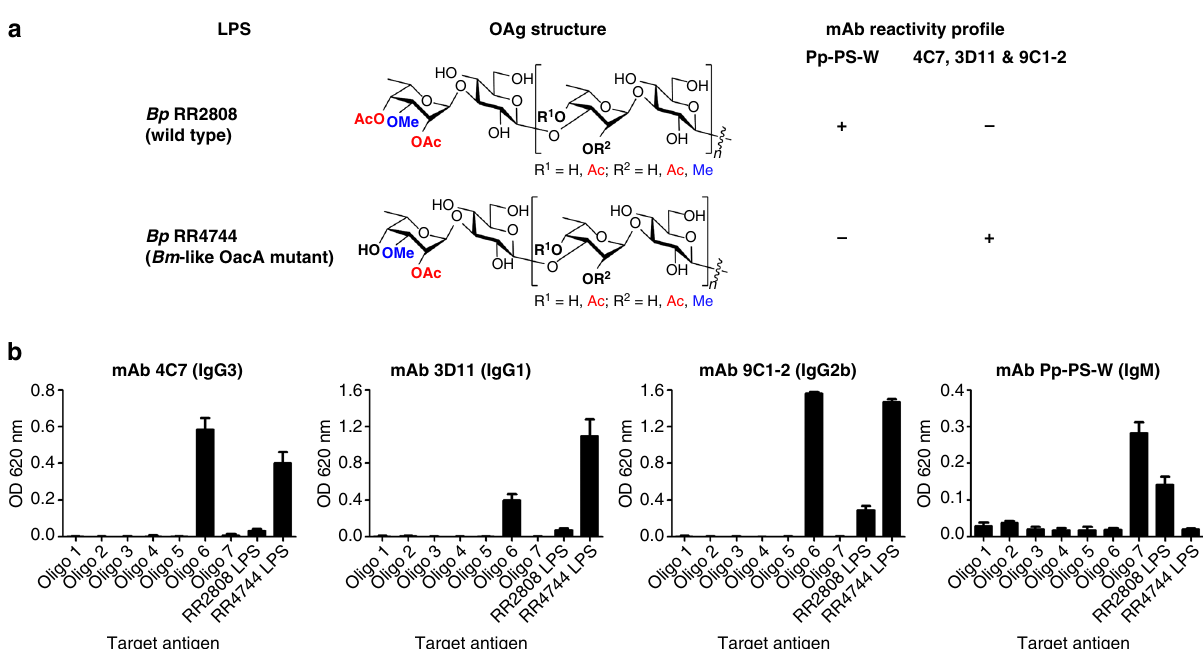
Fig. 5 Interactions of LPS-speci fi c mAbs with synthetic oligosaccharides. a Reactivity pro fi les of mAbs Pp-PS-W, 4C7, 3D11, and 9C1-2 with LPS antigens puri fi ed from Bp strains RR2808 and RR4744 (see Supplementary Fig. 167). b Reactivity pro fi les of the mAbs with synthetic oligosaccharides 1 – 7 , RR2808, and RR4744 LPS as determined by ELISA. Black bars represent the mean ± sd of assays conducted in